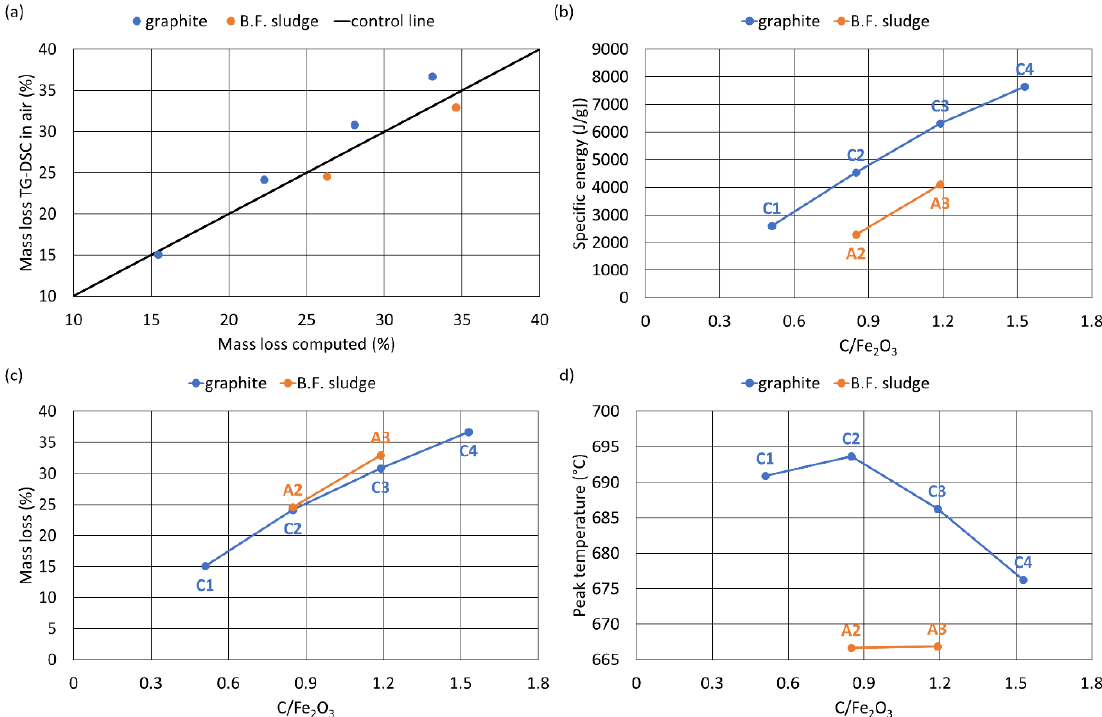
Figure 4. Comparison of the calculated and measured mass loss ( a ), specific energy of CO / CO 2 formation peak ( b ), total mass loss ( c ), and peak temperature of the C combustion ( d ) as a function of C / Fe 2 O 3 ratio. Air atmosphere.